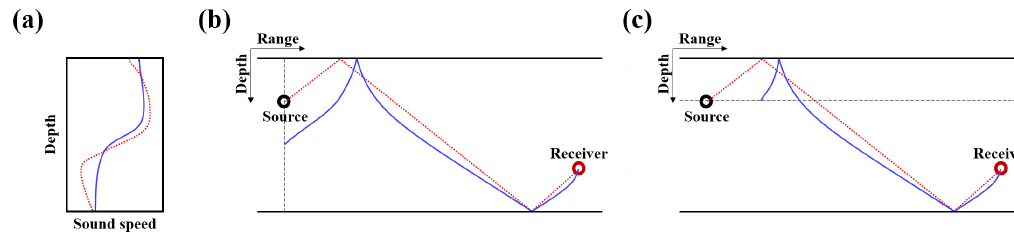
Figure 1. ( a ) the reference (solid line) and ocean (dotted line) sound speed profiles. The corresponding ray trajectories given in ( b , c ) show the vertical difference at the source range and the horizontal difference at the source depth,